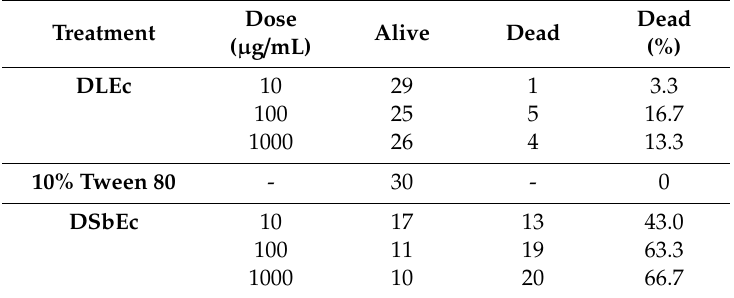
Table 7. Toxic e ff ect of extracts on brine